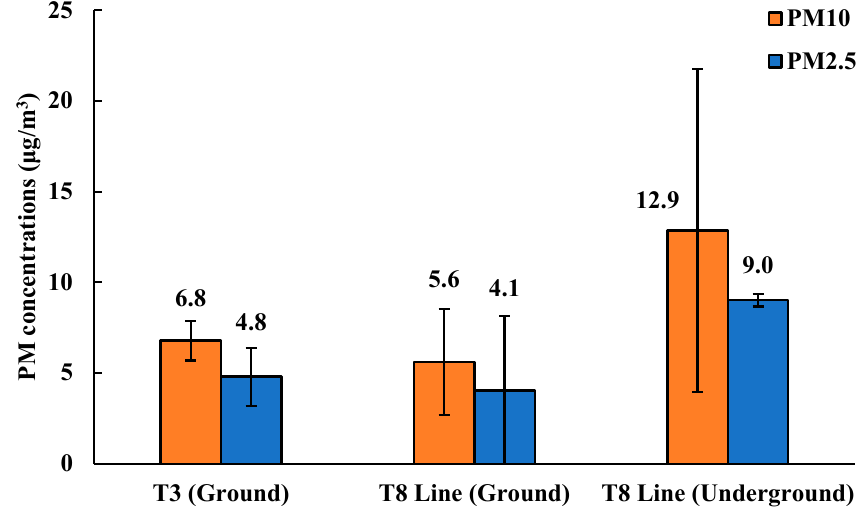
Figure 4. Average PM concentrations inside the train carriages from T3 line (measured over three months from November 2021 to January 2022), and T8 line (measured from April to May 2021).